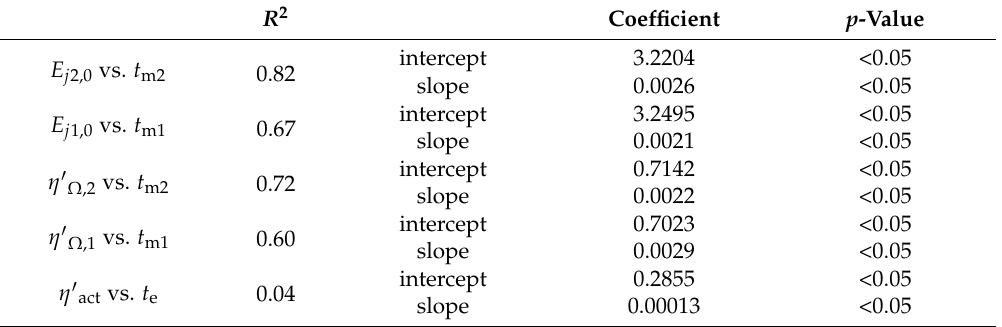
Table 1. Regression analysis of the E ji ,0 , η Ω ,I (cid:48) and η act (cid:48) as a function of the respective service times. R 2 p -Value